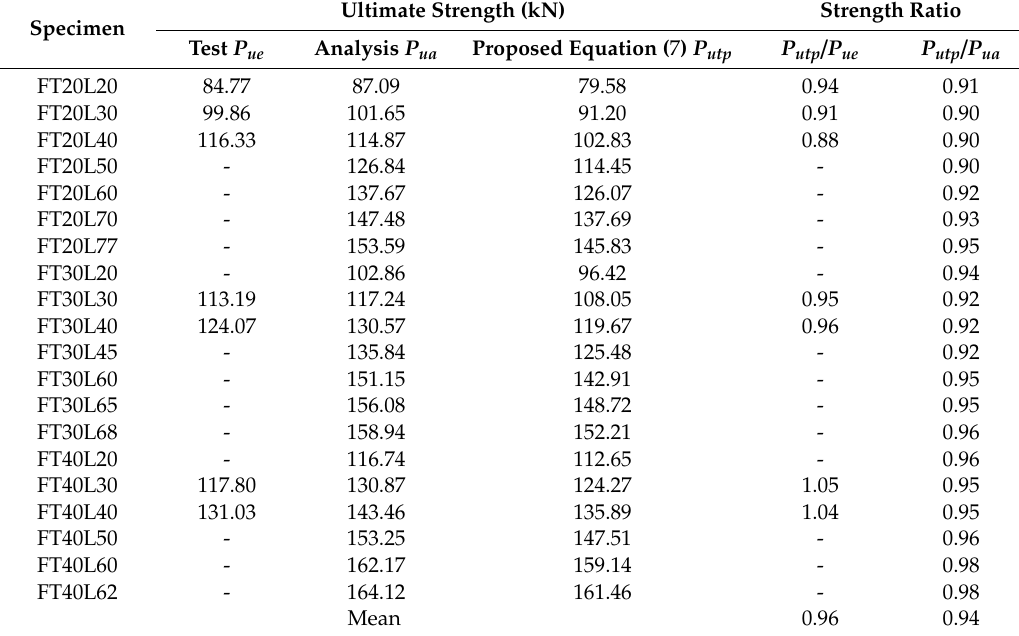
Table 8. Comparison of test result, analysis prediction, and strength of the proposed